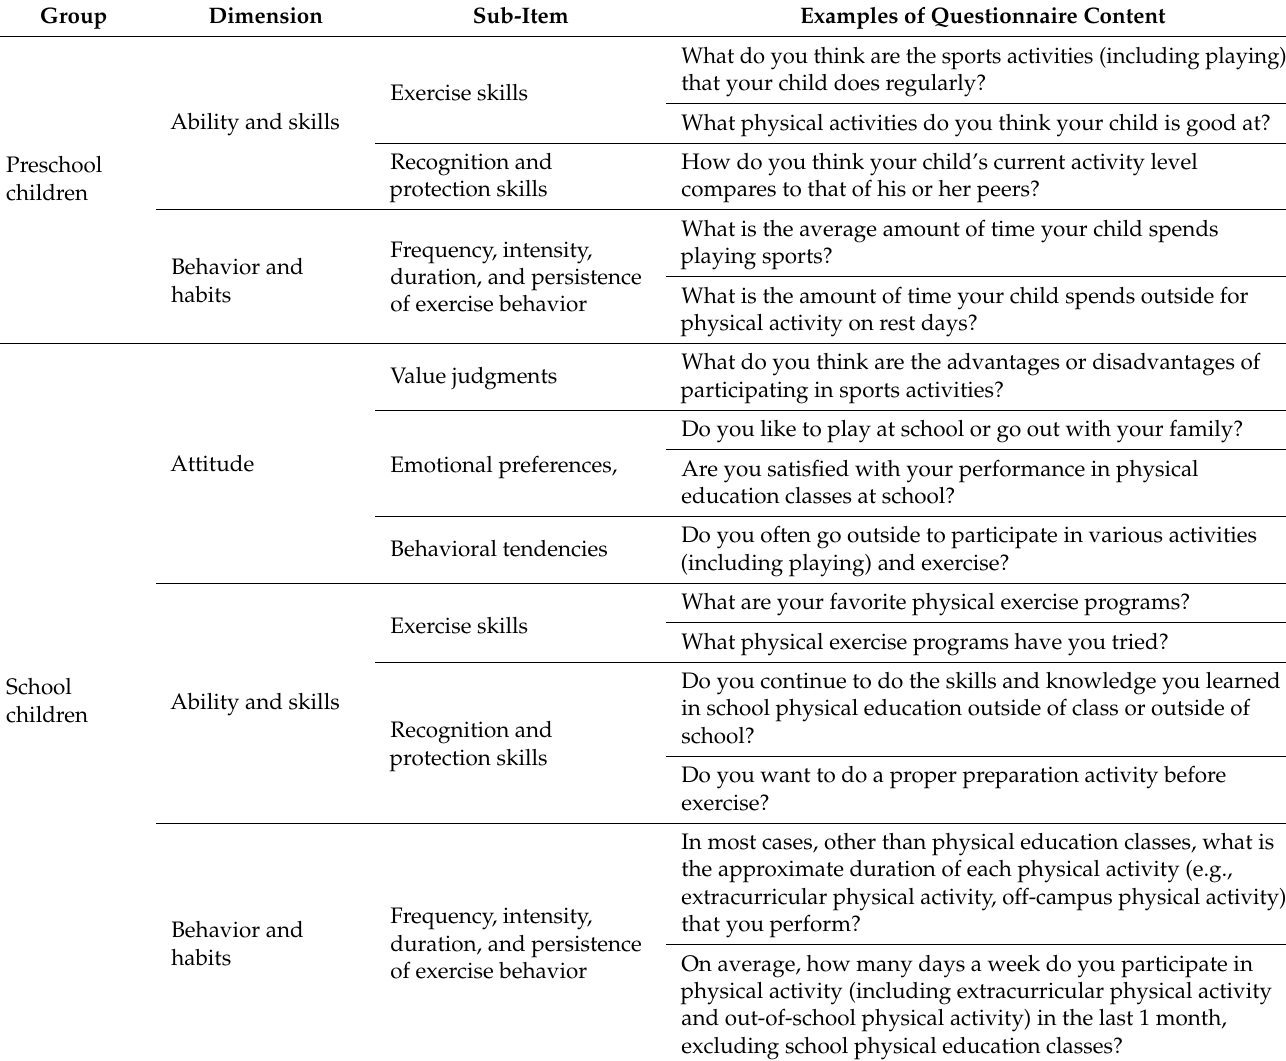
Table 1. Dimensions, sub-items, and questionnaire examples for measuring scientific fitness